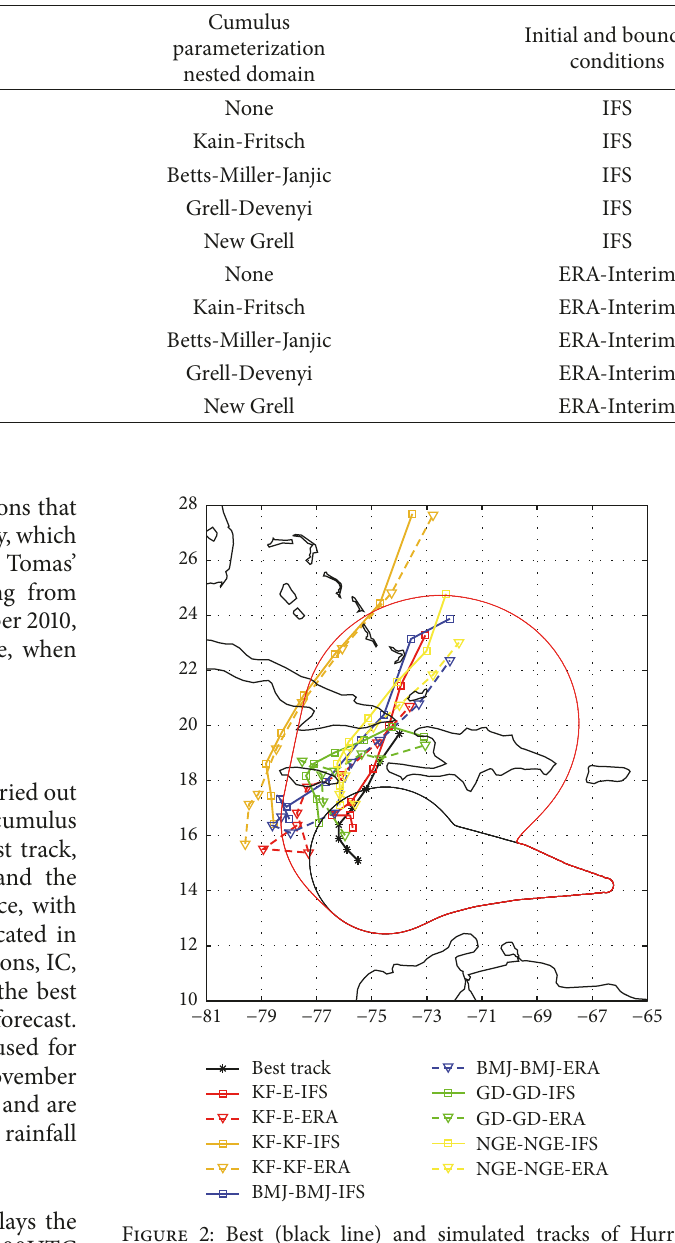
Figure 2: Best (black line) and simulated tracks of Hurricane Tomas from 00UTC on 4 November to 18UTC on 5 November 2010 are presented. NHC’s track forecast cones for 3 (thin black line) and 5 (thin red line) days are also shown. All the simulations encompass the time period from 00UTC on 1 November to 00UTC on 6 November 2010, which includes the Tomas increasingly dis- organised phase (from 00UTC on 1 November to 00UTC on 3 November) and the subsequent rapid intensification phase (from 06UTC on 4 November to 06UTC on 5